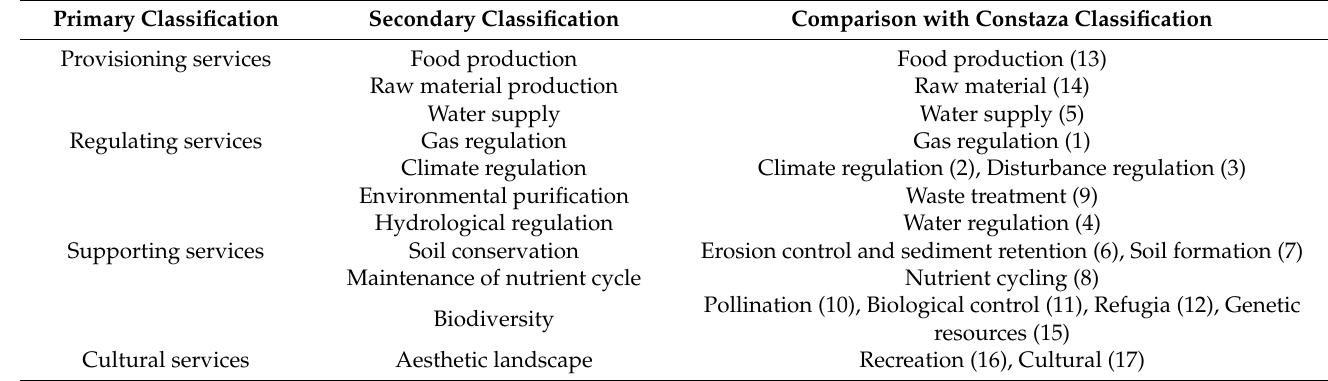
Table A2. Classification of ecosystem services